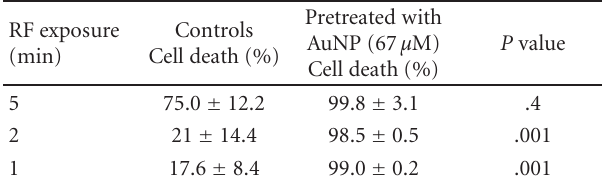
Figure 4: Concentration-dependent heating rate of Kentera SWNT suspensions under 600W of RF generator output power. Sus- pensions exhibited nonlinear heating rates with increasing SWNT concentration. Shown are the averages of the heating rates for Ken- tera SWNTs (dots) and the calculated SWNT heating contribution (triangles). Reproduced with permission from Cancer, vol. 110, no. 12, pp. 2654–2665, 2007. Table 1: Non-invasive RF field treatment of Hep3B cells: cell viability was assessed by Propidium Iodide-Fluorescent Activated Cell Sorting (PI-FACS) 18 hours after RF